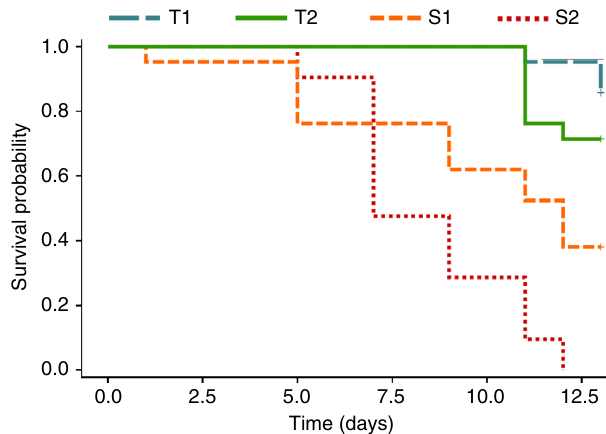
Fig. 1 Survival in the four Daphnia genotypes used in the transplant experiments following cyanobacterial exposure. Colored lines indicate the different genotypes (tolerant genotypes: T1 and T2 , in blue and green, respectively; susceptible genotypes: S1 and S2 , in orange and red, respectively). The two tolerant genotypes ( T1 and T2 ) exhibited similar survival patterns ( p = 0.26), and survived longer than the two susceptible genotypes ( S1 and S2 ; p = 0.002, p < 0.0001, p = 0.02 and p < 0.0001 for T1 – S1 , T1 – S2 , T2 – S1 , and T2 – S2 pairwise comparisons, respectively). Among susceptible genotypes, S1 had a higher survival rate than S2 ( p = 0.001). p values were obtained from a Cox model. Sample size was n = 21 (7 individuals × 3 biological replicates) for each